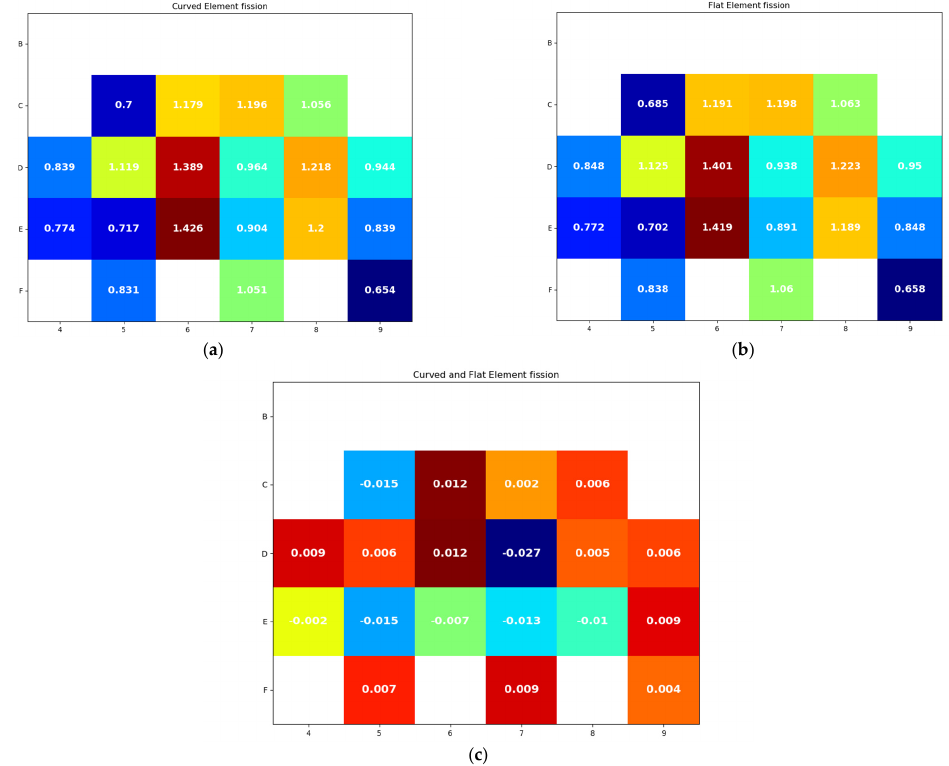
Figure 13. Radial fi ssion distribution of ( a ) curved fuel, ( b ) fl at fuel, and ( c ) the di ff erence.